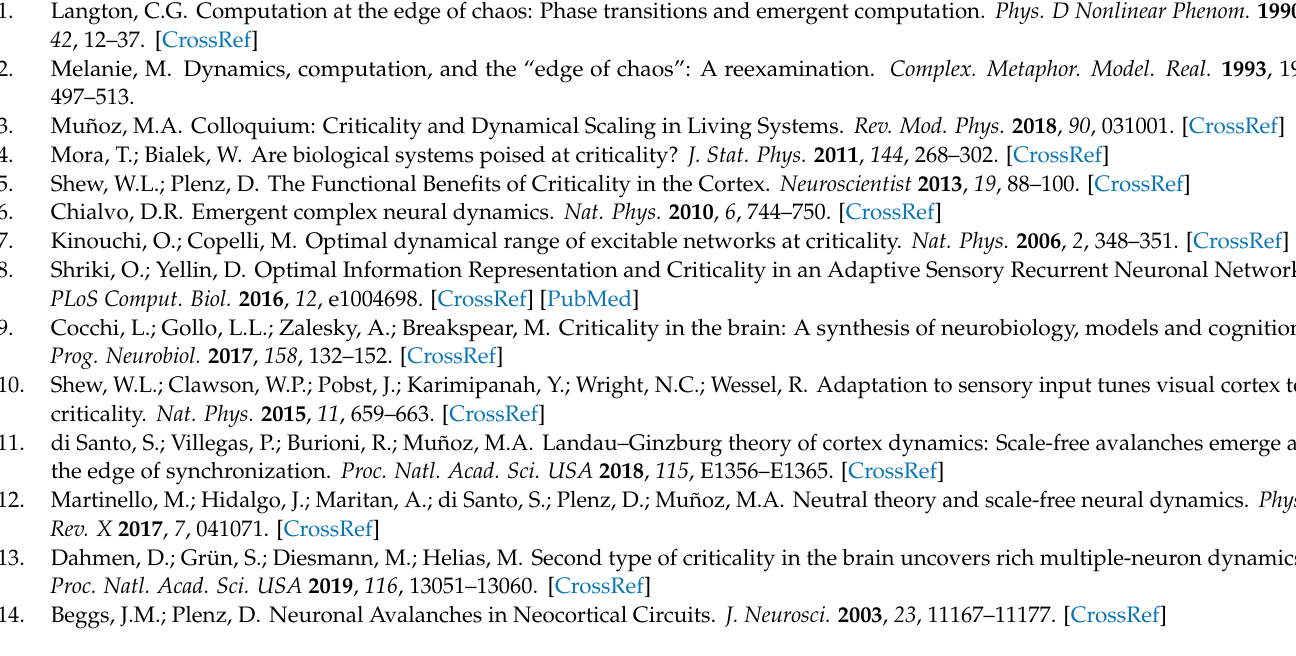
Figure A1. Activity of four different neurons operating in the sub-critical, critical and super-critical regimes (from top to bottom) when presented with three different high-dimensional, natural images. Each point in the panels represents the activity x i ( t ) of neuron i at a different time step t as a function x j ( t − 1 ) arriving to w in u l ( t ) + ∑ N w res of the total input f i ( t ) = ε ∑ L 1 j = 1 ij il l = 1